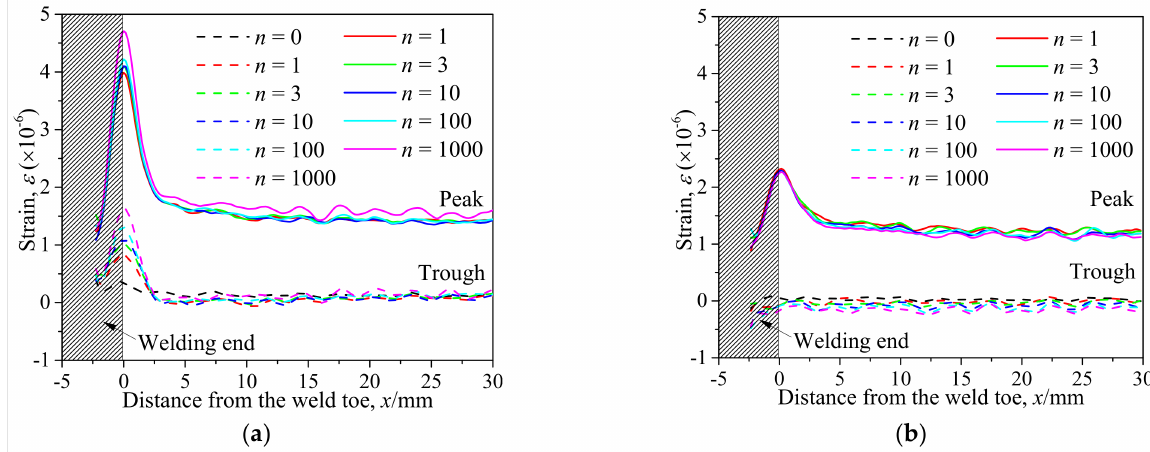
Figure 6. Strain distribution along the central axis X-X ’: ( a ) Specimen AW; ( b ) Specimen